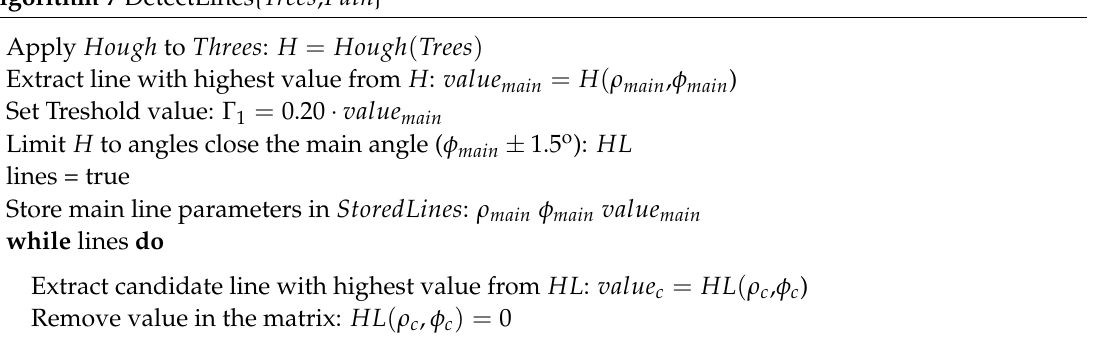
Algorithm 7 DetectLines{ Trees , Path